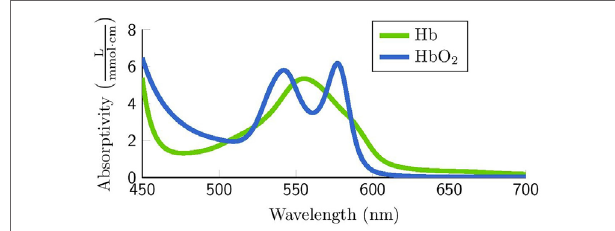
FigURe 1 | Hemoglobin (green) and oxyhemoglobin (blue) absorption spectra (Jensen and Hannemose, 2014).